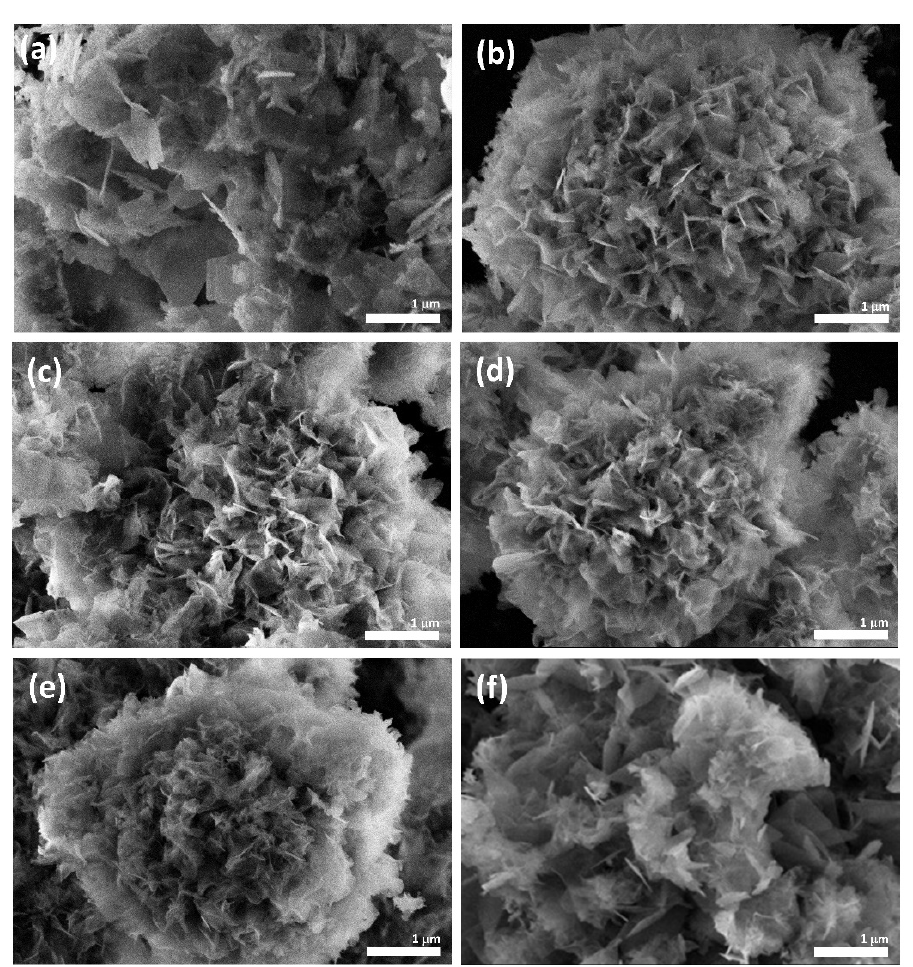
Figure 5. SEM micrographs of the precipitates formed after 60 min reaction time (150 min in the case of Ser) in ( a ) control system and in the presence of 5 mmol dm –3 ( b ) aspartic acid (Asp), ( c ) lysine (Lys), ( d ) asparagine (Asn) ( e ) serine (Ser) and ( f ) phenylalanine (Phe). c (CaCl 2 · 2H 2 O) = c (Na 2 HPO 4 ) = 5 mmol dm –3 , c (NaCl) = 0.15 mol dm –3 , c (AAs) 5 mmol dm –3, pHinitial = 7.4, ϑ = (25.0 ± 0.1) °C, magnetic stirring.